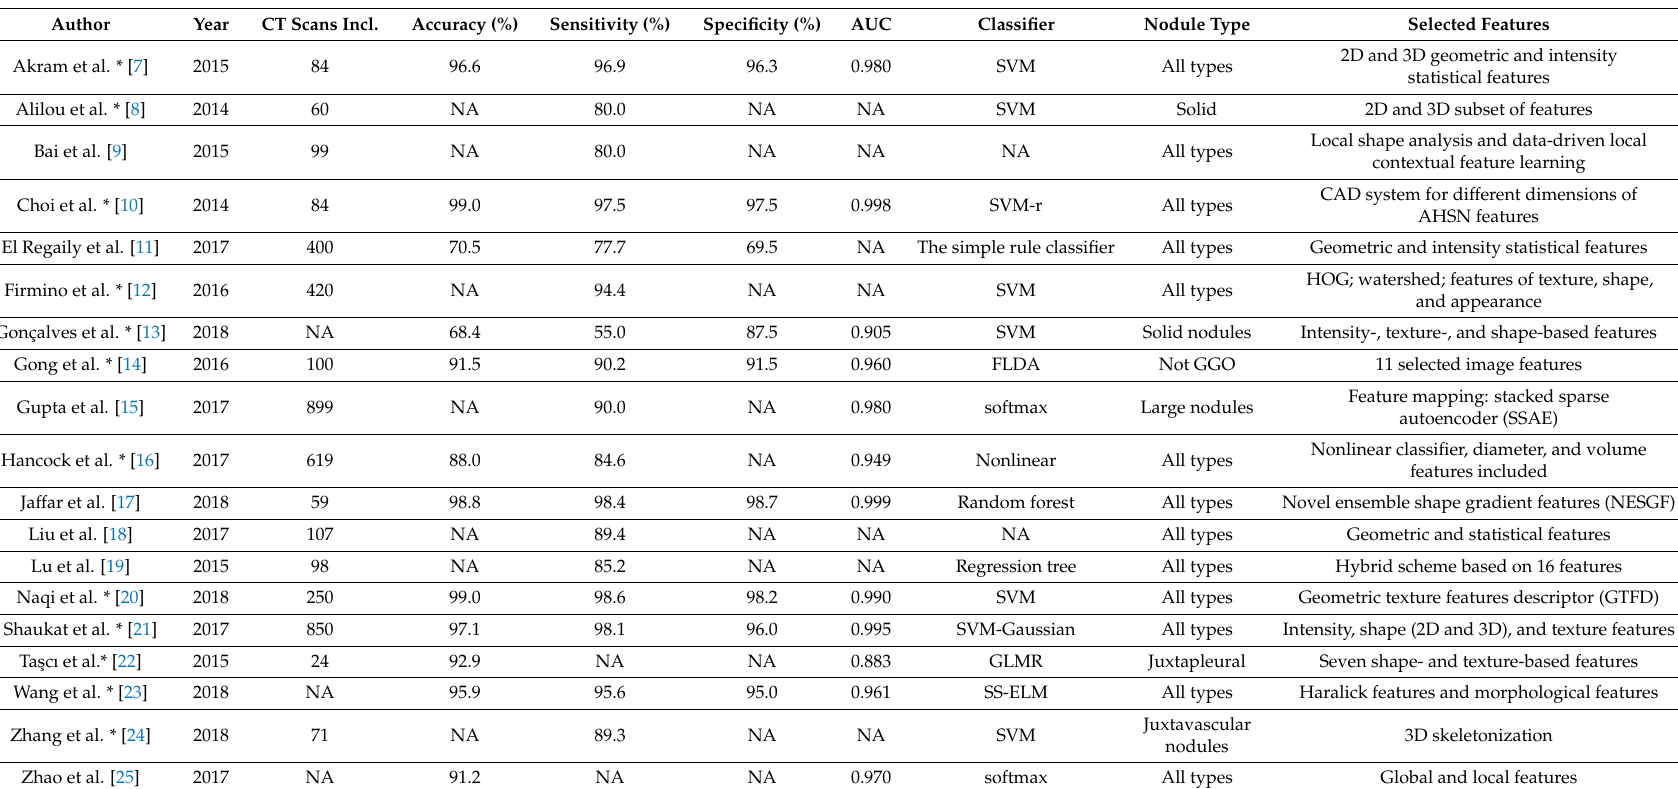
Table 1. Feature-based algorithms applied to the Lung Image Database Consortium Image Collection (LIDC-IDRI)